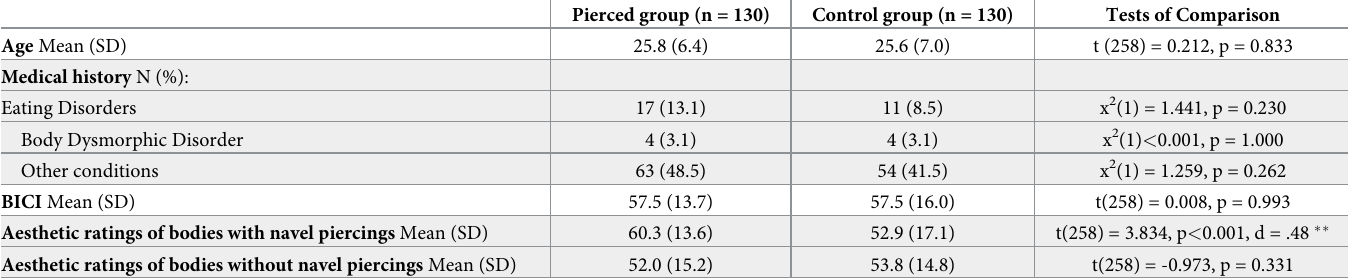
Table 3. Sample characteristics, BICI scores and aesthetic ratings. Tests of comparisons used chi square and independent-sample t-tests. Asterisks denote significant differences between groups.